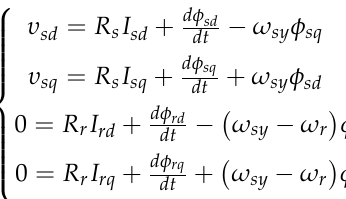
− 𝛾 for various pitch angles. (cid:3043)(cid:3042)(cid:3050)(cid:3032)(cid:3045)